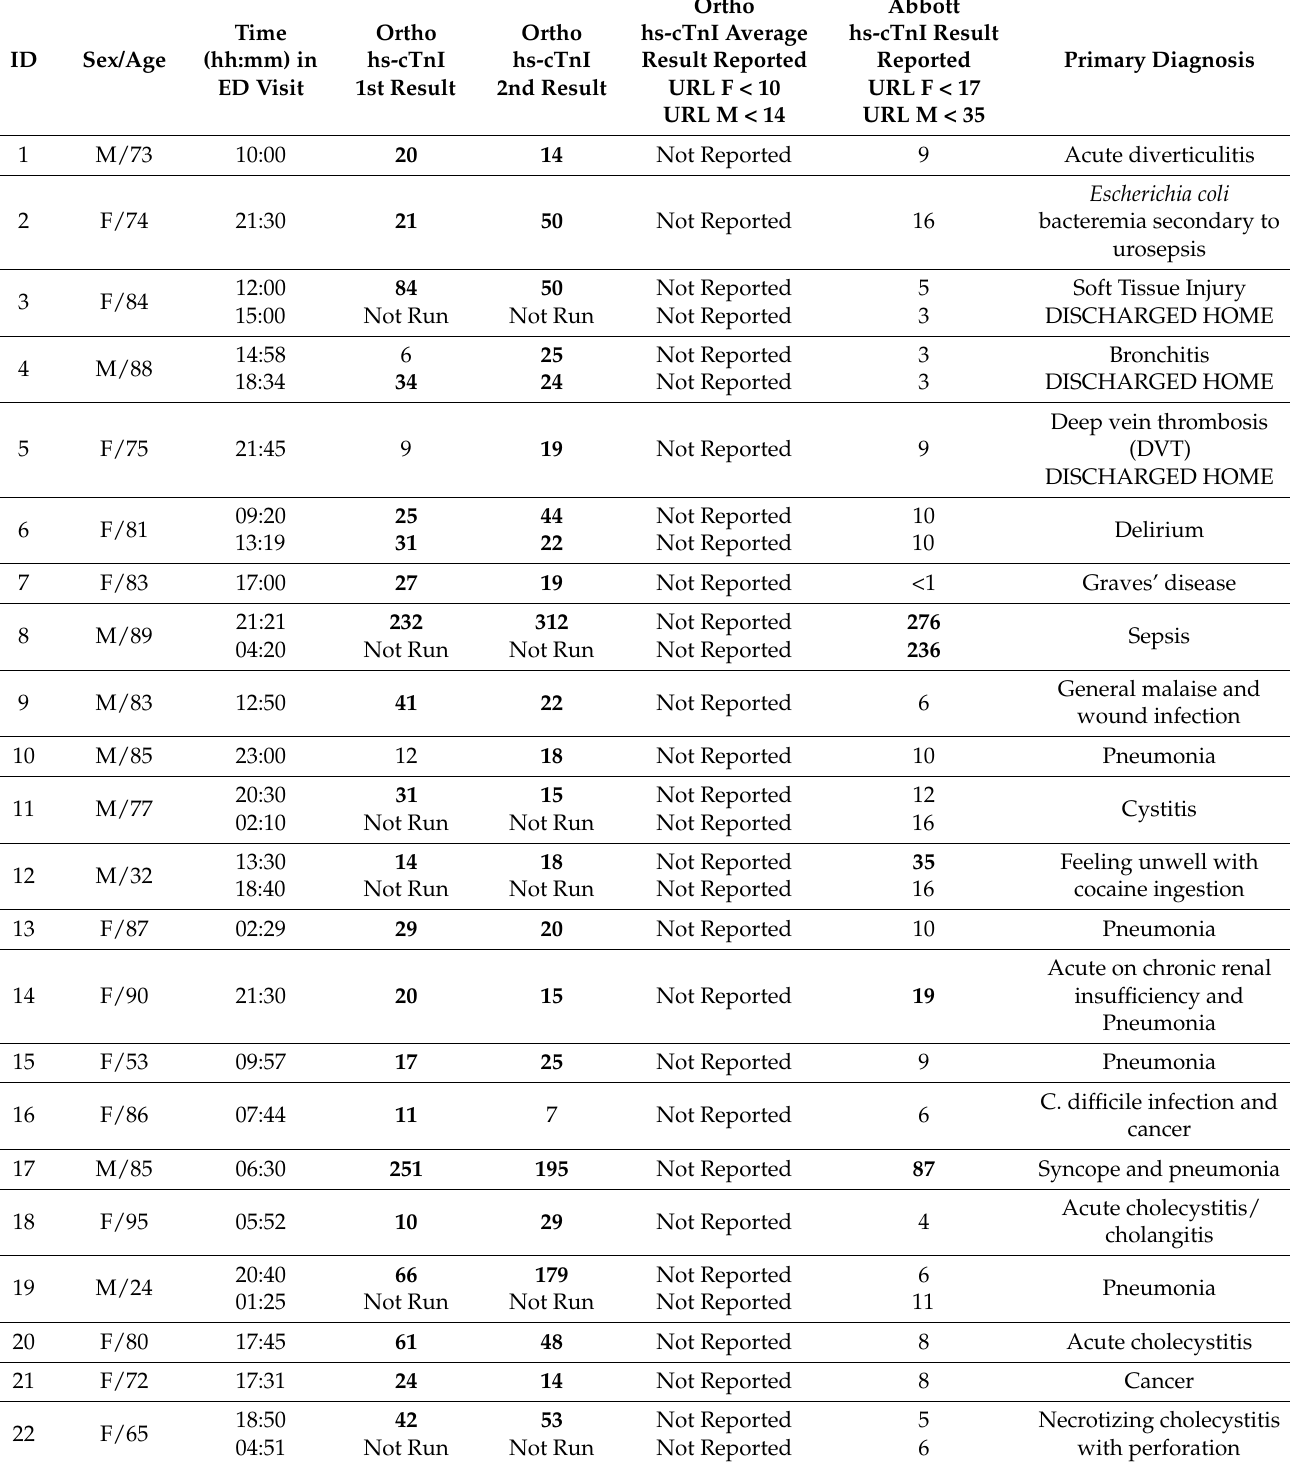
Table 2. Details of the 37 ED patients with the Ortho hs-cTnI average result from EDTA plasma not reported (i.e., not reported due to repeat measurement exceeding limits or technologist reviewing previous results and noting that Ortho hs-cTnI assay provided discrepant results in patient). The bolded concentrations identify levels above the 99th-percentile upper reference limits (URLs) (note: EDTA plasma only recommended sample type for Abbott hs-cTnI by United States Food and Drug